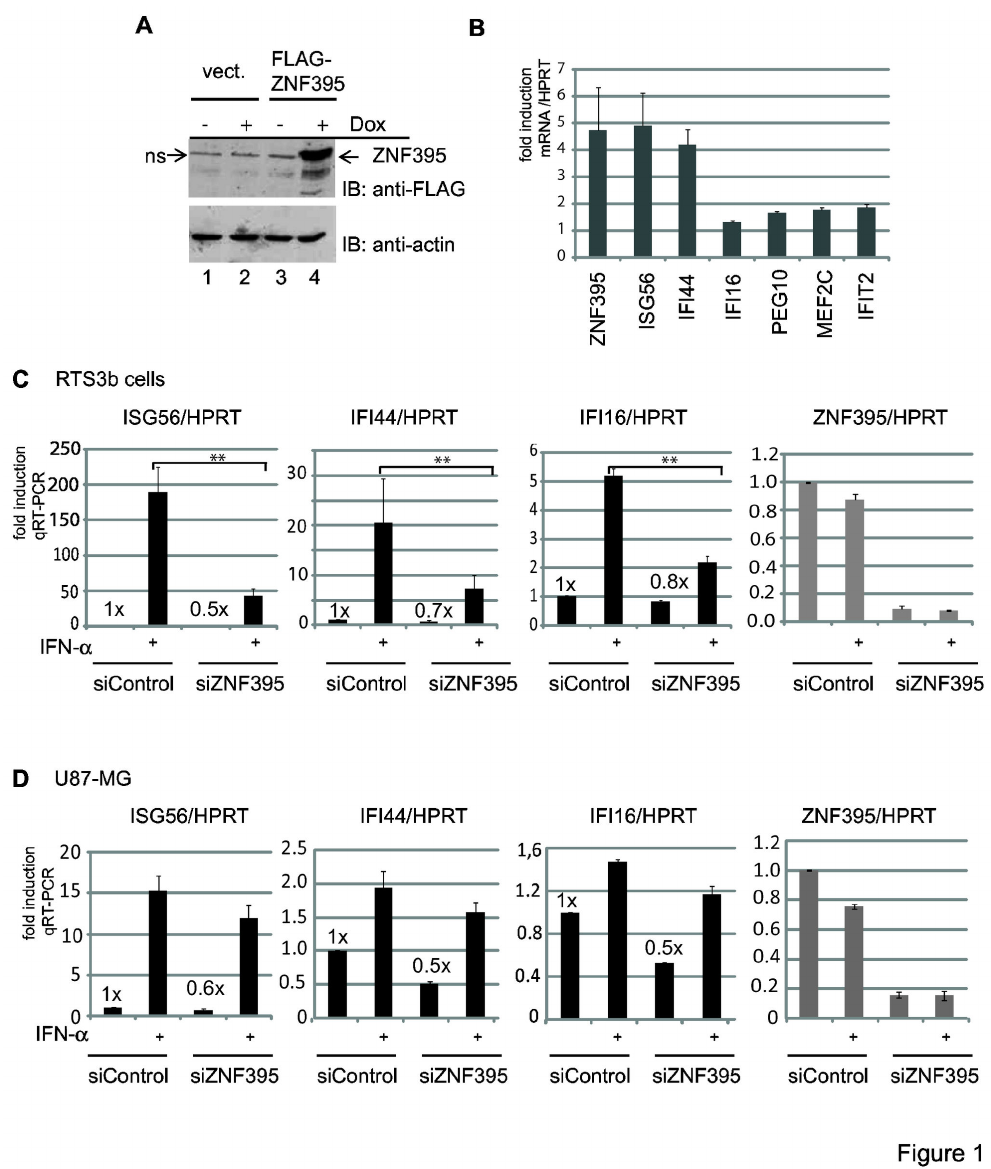
Figure 1. ZNF395 activates innate immune response and cancer-associated genes. ( A ) Stably transfected RTS3b cells expressing the tet repressor and FLAG-tagged ZNF395 under control of the tet inducible promoter (lanes 3, 4) or the empty vector pcDNA4/TO (lanes 1, 2) were either grown in the absence (lanes 1, 3) or presence of Dox (lanes 2, 4) for 24h. Extracts were used for ImmunoBlot (IB) which was developed with the FLAG antibody and an anti-actin antibody as control. ns (non specific band) ( B ) Total RNA isolated from RTS3b TR-FLAG-ZNF395 cells, either grown with or without Dox was used for qRT-PCR to analyze the expression of the factors shown in the graph. The corresponding values were normalized to the values for the housekeeping gene hypoxanthine guanine phosphoribosyl transferase (HPRT) and those obtained from cells grown in the absence of Dox were set as 1 for each factor. The graph represents the means of two independent experiments each performed in duplicate. The error bars represent the standard deviations. ( C , D ) RTS3b and U87-MG cells were transfected with control siRNA or siRNA targeting ZNF395 in duplicate. One set of samples was treated with solvent and the other with IFN-α, before total RNA was isolated. QRT-PCR was performed with the specific primer to amplify ISG56, IFI44, IFI16 and ZNF395 transcripts. CP-values obtained for the various factors were normalized against those for the housekeeping gene HPRT. The value with RNA from solvent treated cells transfected with siControl was set as 1 in each case. The fold activations were calculated according to the comparative threshold method described in Pfaffl et al. [64]. QPCRs were performed four times and the standard deviations are given. The values provided in the figure reflect the non-induced basal expression level in the absence of ZNF395 (** p <0.01). doi: 10.1371/journal.pone.0074911.g001 PLOS ONE |